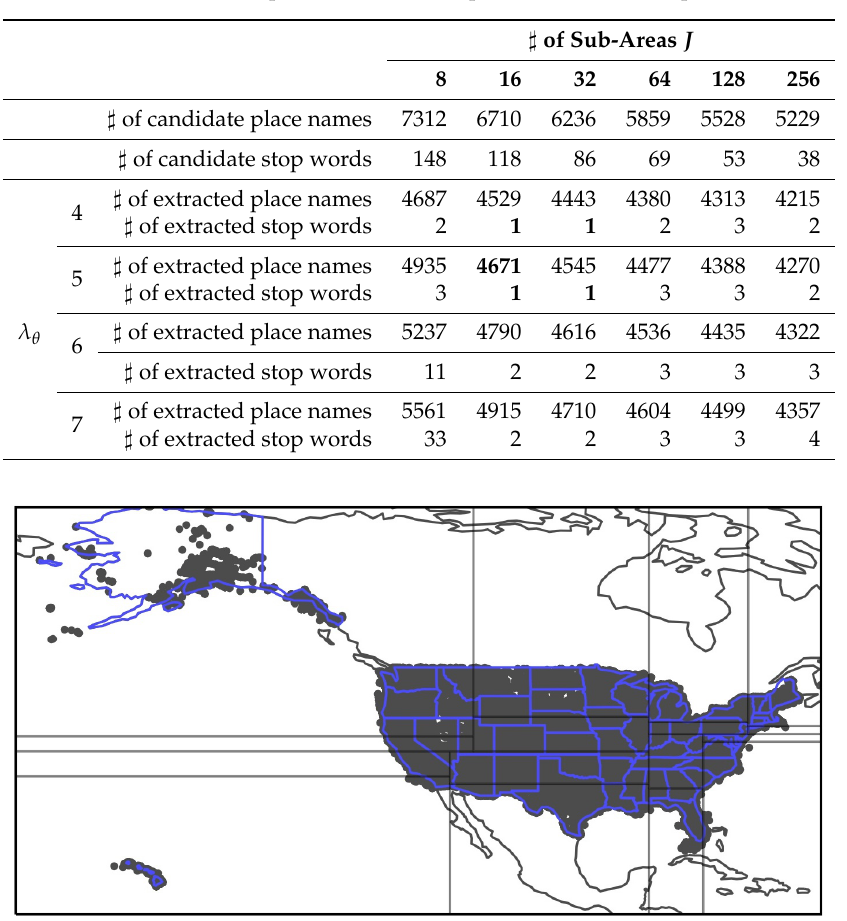
Table 1. Numbers of extracted place names and stop words for different parameters J and θ .